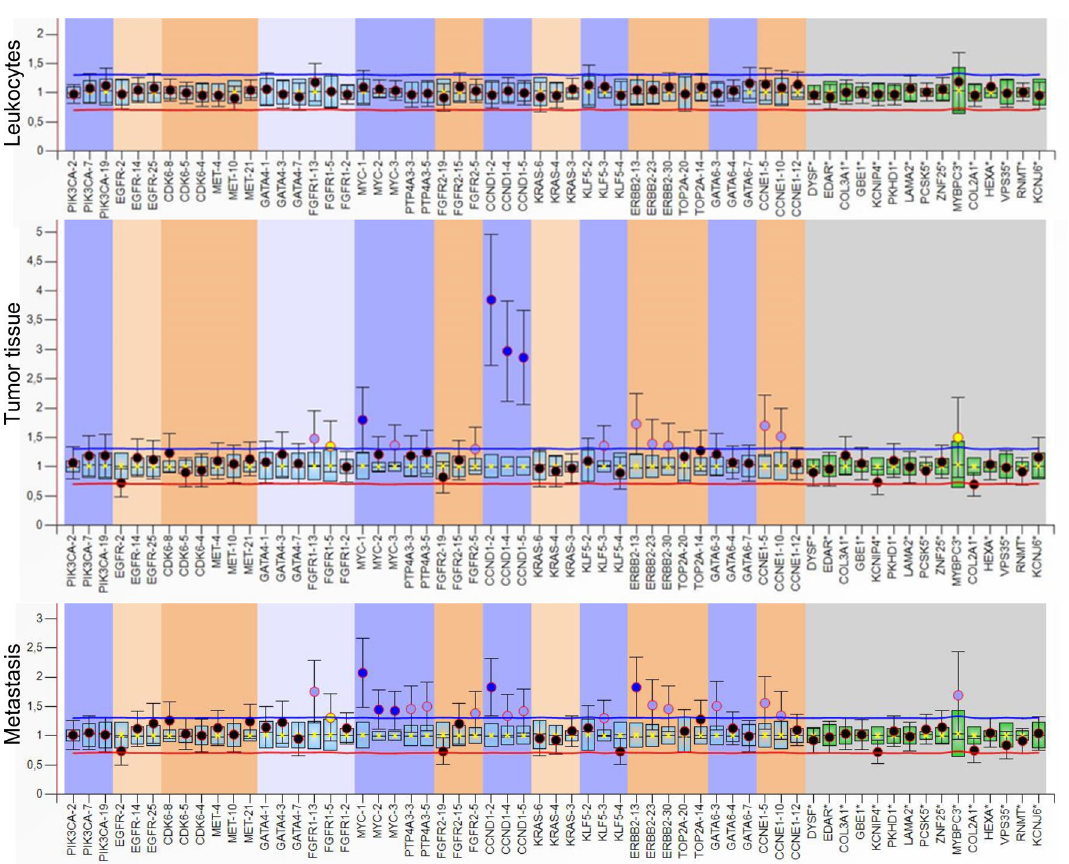
Figure 1. Example of CNV in primary tumor and lymph node metastasis of one patient. The box plot shows data of leukocytes (reference), primary tumor and lymph node metastasis (as calculated by Coffalyser.Net software). The DNA probes are arranged by chromosomal locations. The target-specific probes have a blue and orange background in different hues (left), whereas the reference probes have a grey background (right). Only the dark blue points indicate significant CNV gains, whereas light blue and yellow points are ambiguous and not considered. As expected the leukocyte DNA does not show any CNV. The data were calculated by intra- and inter-sample comparisons. Intra-sample normalization was performed by dividing the fluorescence signal of each target-specific probe by the signal of every single reference probe in this probe. The median of all these ratios of this probe is the normalization constant. Subsequently, inter-sample comparison was performed by dividing the normalization constant of each probe of this sample by the average normalization constant of all reference (leukocyte)